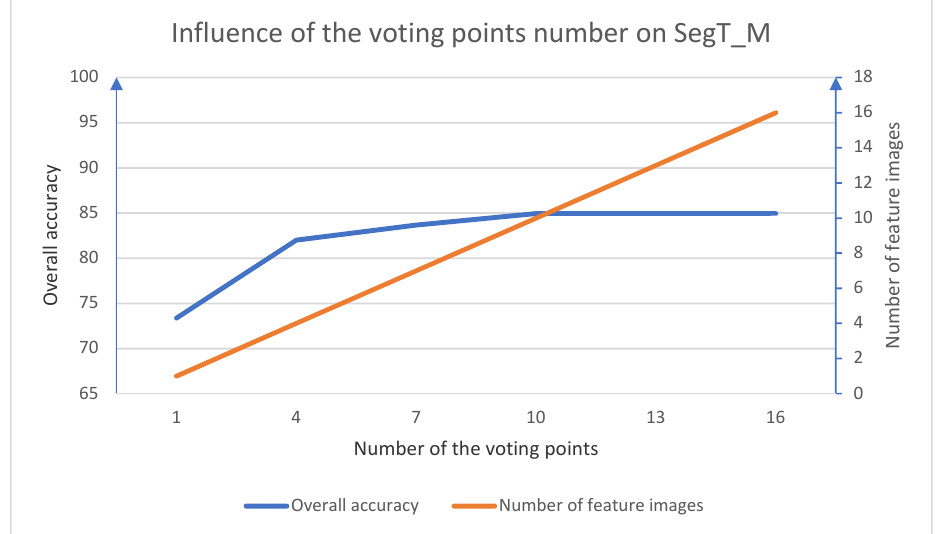
Figure 6. The influence of the voting point number on SegT_M. Table 4. Comparison of the computation time for each strategy.